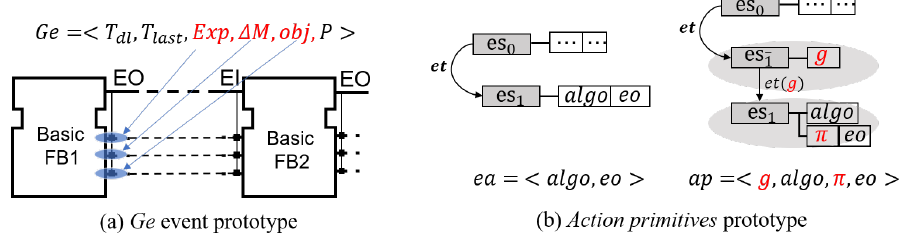
Figure 2. The prototype of GeFB : ( a ) Ge event and ( b ) action